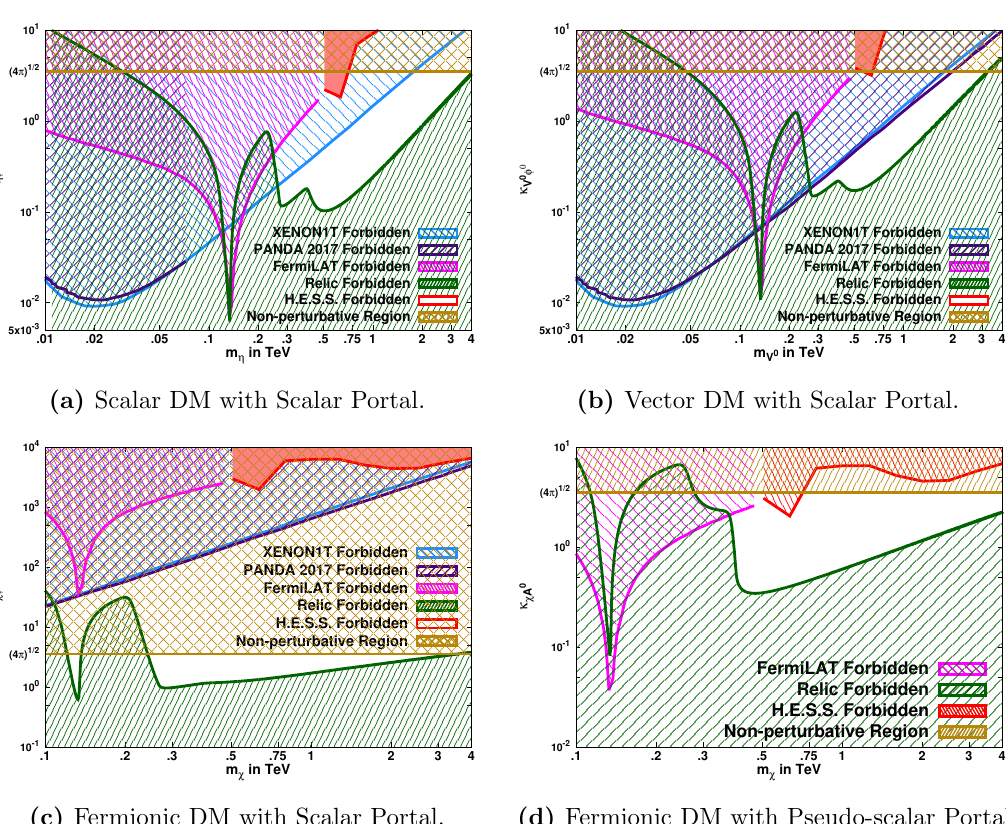
Figure 11. All model constraints are drawn for the portal mass of 270 GeV and VLQ mass 400 GeV. The shaded region correspond to the forbidden regions by relic density [28, 30] (green), XENON1T 2017 [19] (blue), PANDA 2017 [21] (indigo), Fermi-LAT [13] (pink), H.E.S.S. [15] (red) and the perturbativity condition (golden yellow) respectively in the plane de(cid:12)ned by m (cid:17) (cid:0) (cid:20) m (cid:0) (cid:20) , m (cid:31) (cid:0) (cid:20) and m (cid:31) (cid:0) (cid:20) in (cid:12)gures 11a, 11b, 11c, and 11d respectively. Constraint V 0 V 0 (cid:30) 0 (cid:31)(cid:30) 0 (cid:31)A 0 from the direct detection experiments for the pseudo-scalar portal are not shown (see